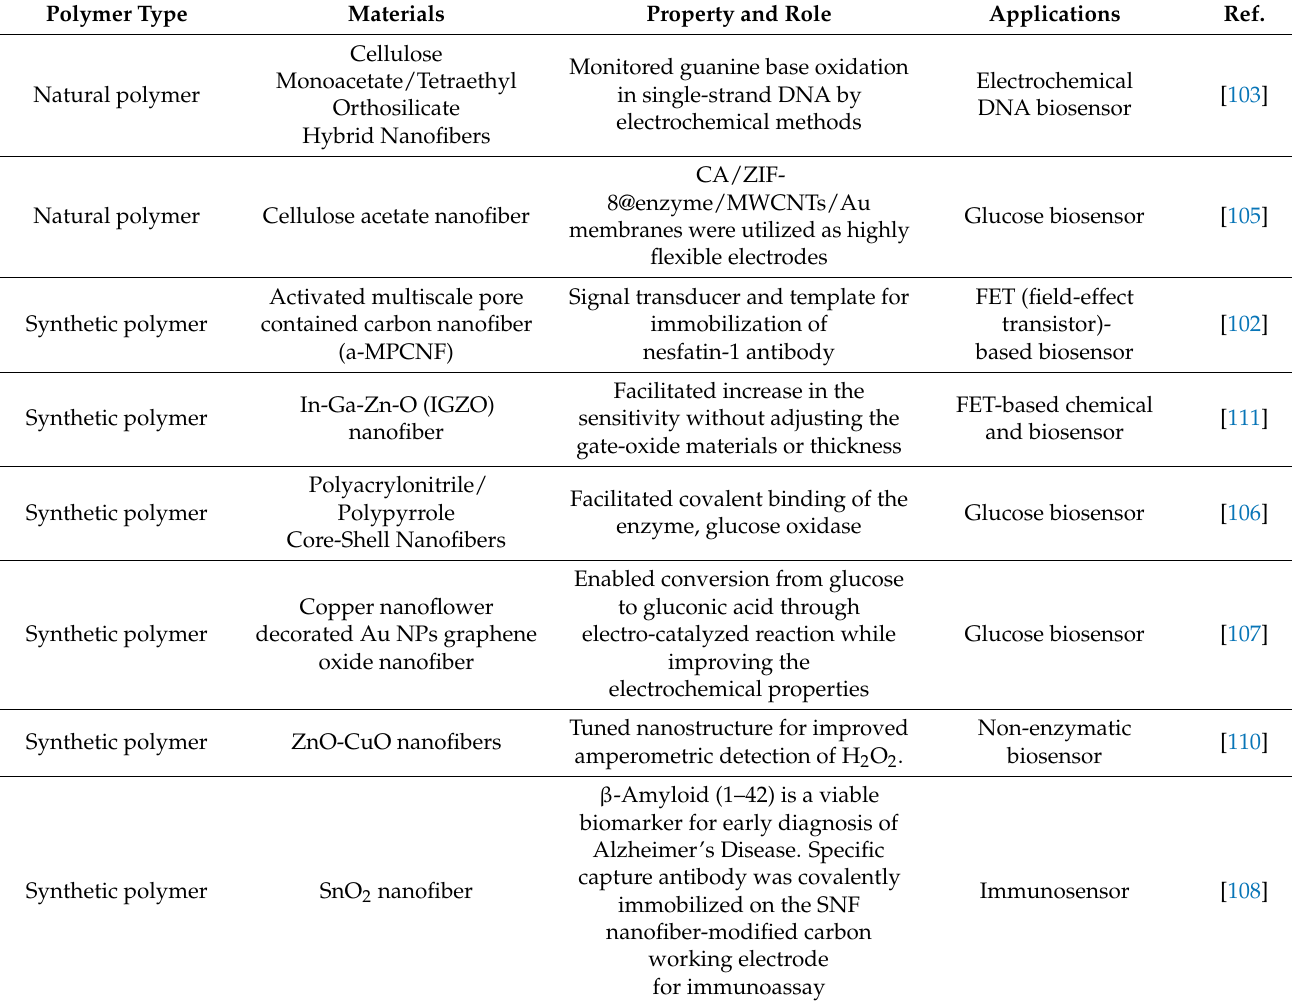
Table 1. Role of nanofiber materials in various biosensing